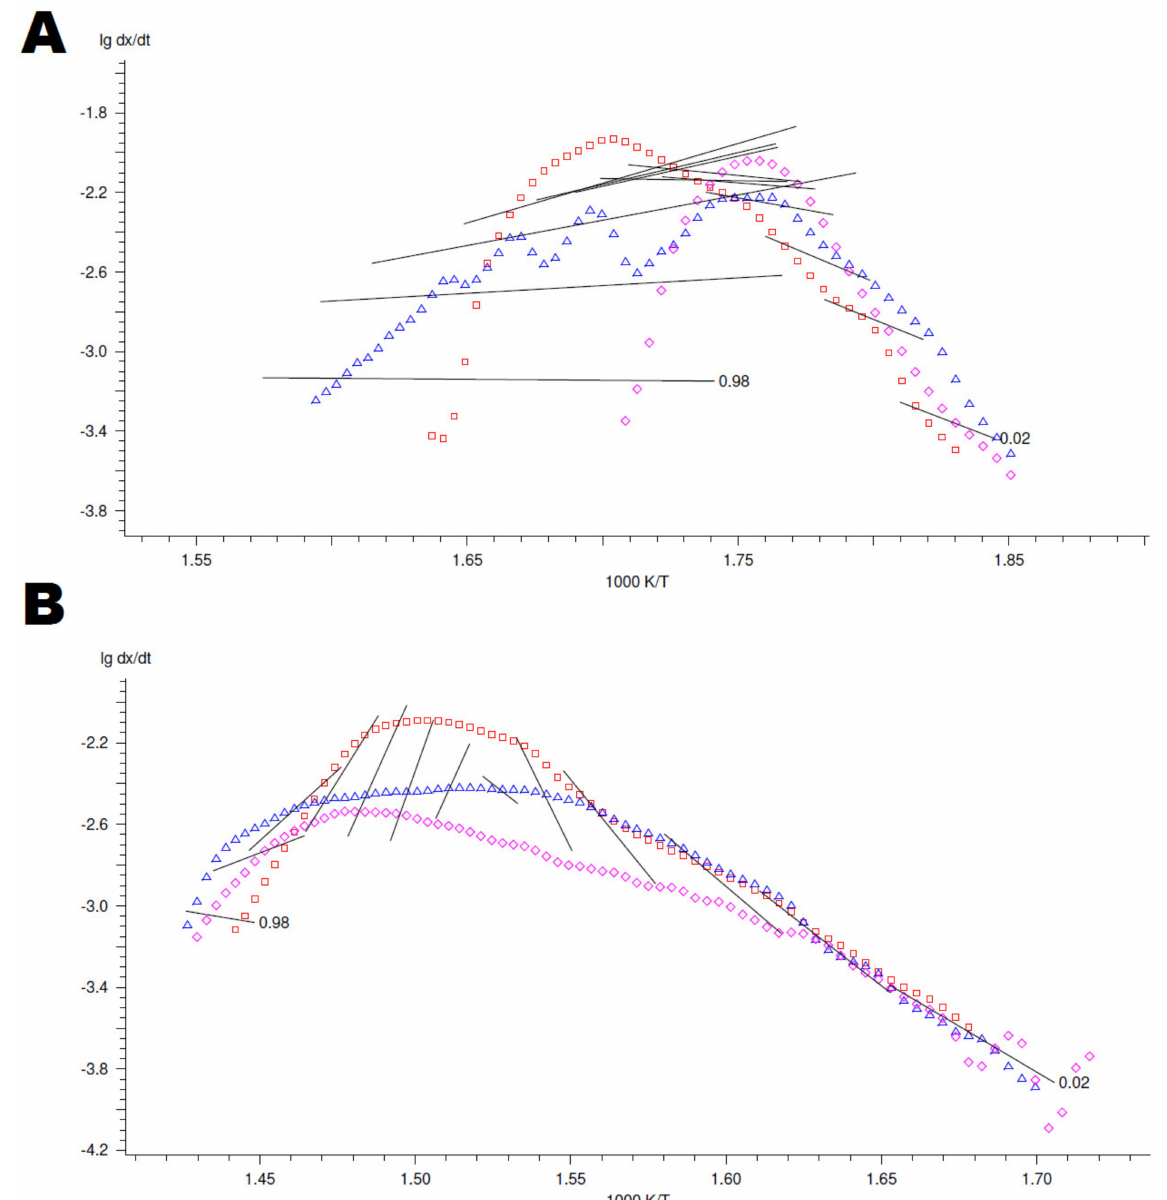
Figure A3. Friedman POM-R analysis plot lg (reaction rate) vs. 1000 K/T: ( A ) sample investigated in an oxygen atmosphere; ( B ) sample investigated in an inert atmosphere. Lines are drawn through isoconversion points for the measurement with 10 ( ♦ ), 15 ( ∆ ), and 20 ( (cid:3) ) ◦ C/min heating